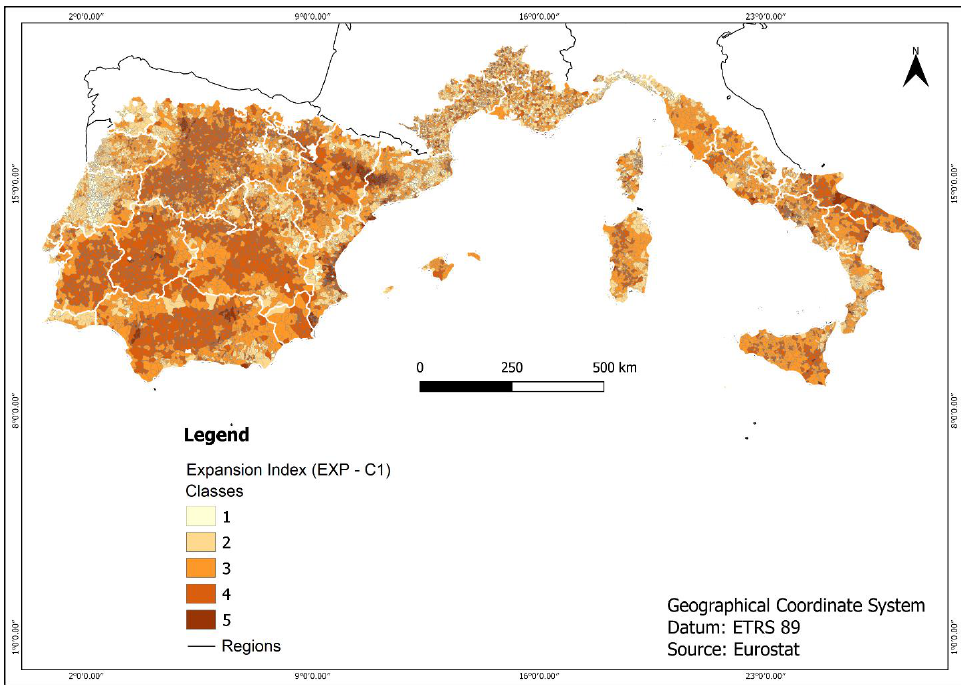
Figure 9. Map of spatial distribution of LAUs among the five intensity classes of EXP for the 1st census date (C1). The spatial pattern of the SPE in C1 seems to be partially correlated to the EXP index distribution (Castilla y Leon and Andalucía) and locally affected by the proximity of LAUs to touristic areas (Figure 10).